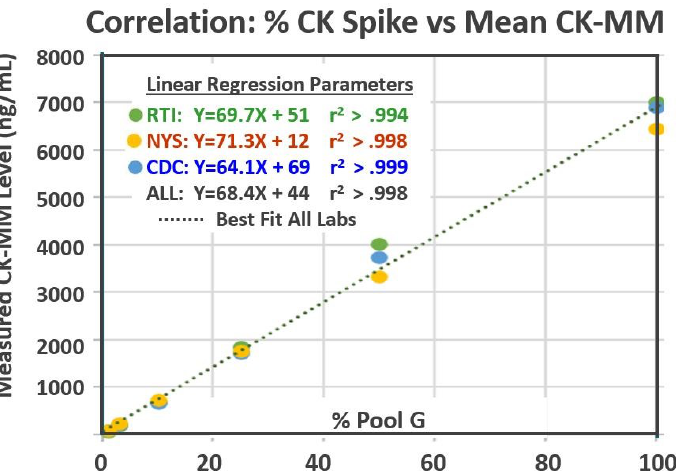
Figure 1. Correlation between the percentage of Pool G in Pools B–G and the mean CK-MM levels measured within each of the three laboratories.